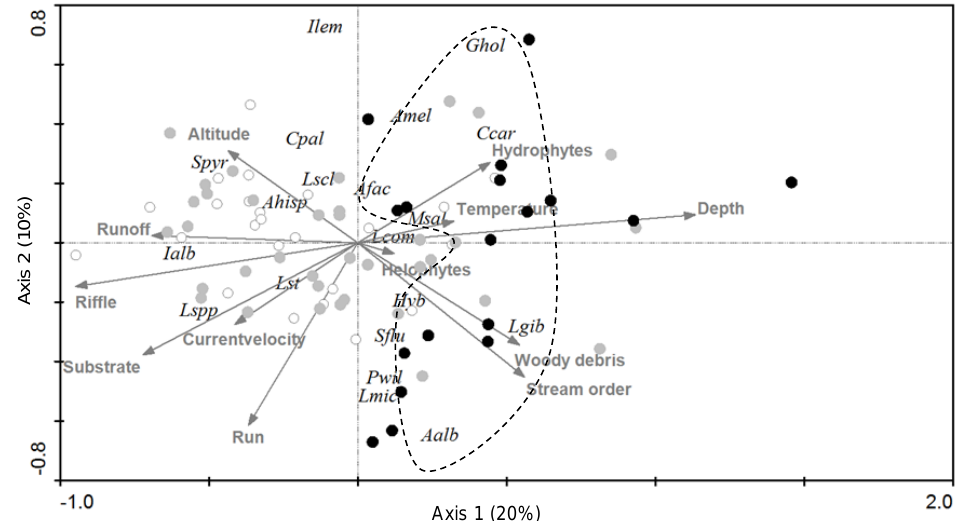
Figure 2. Ordination diagram (triplot) of the Redundancy Analysis between fish species and environmental variables (both regional and local). Sampling sites are coded according to the classes of anthropogenic disturbance level defined: least disturbed (white dots), moderately disturbed (grey dots) and most disturbed (black dots). Species abbreviations: Anaecypris hispanica (Ahisp), Iberocypris alburnoides (Ialb), Iberocypris lemmingii (Ilem), Squalius pyrenaicus (Spyr), Cobitis paludica (Cpal), Luciobarbus spp.—juveniles (Lspp), Luciobarbus sclateri (Lscl), Luciobarbus steidachneri (Lst), Luciobarbus comizo (Lcom), Luciobarbus microcephalus (Lmic), Pseudochondrostoma willkommii (Pwil), Salaria fluviatilis (Sflu), Gambusia holbrooki (Ghol), Ameiurus melas (Amel), Cyprinus carpio (Ccar), Micropterus salmoides (Msal), Lepomis gibbosus (Lgib), Alburnus alburnus (Aalb), Hybrids (Ialb × Aalb). Non-native species are enclosed by a dashed line.